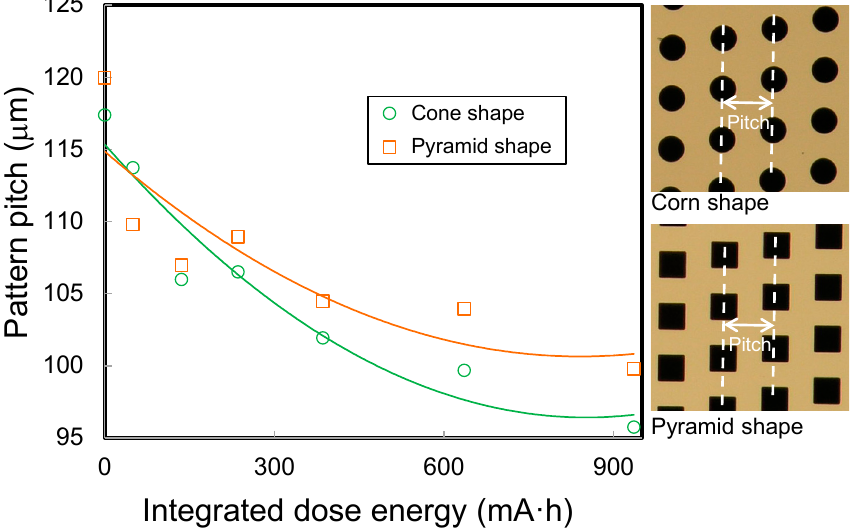
Figure 10. Pattern pitch of PMMA structures which cone, and pyramid shapes of Si absorbers was transferred by X-rays depended on the integrated dose energy. Pitches in X and Y directions indicated as P x and P y in the figure,